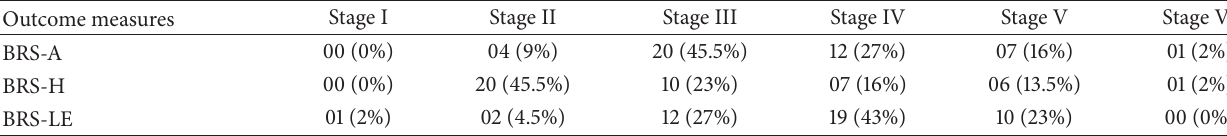
Table 2: Description of motor recovery and balance measures.